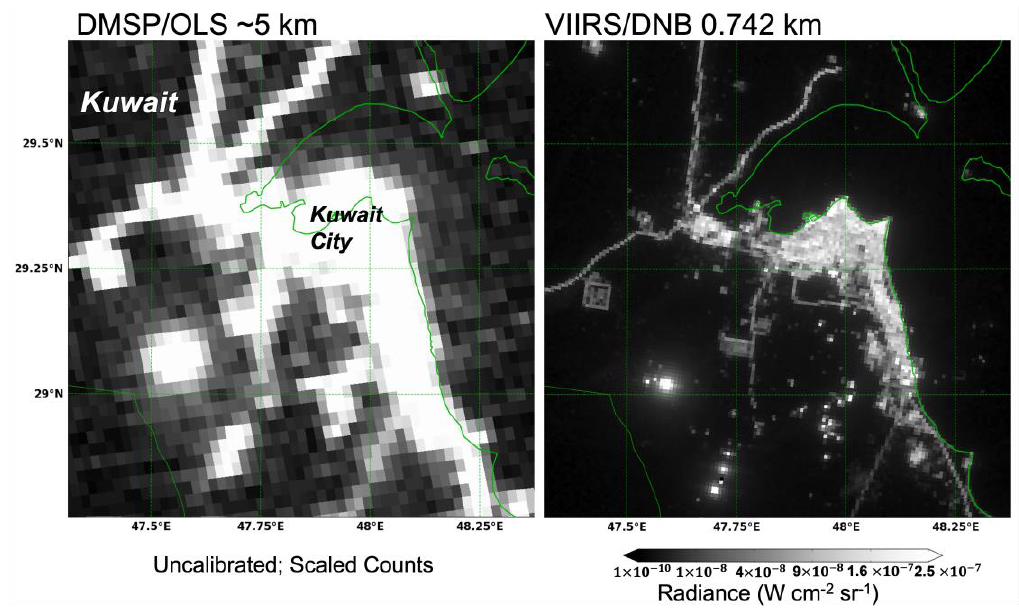
Figure 1. Comparison between a DMSP/OLS and VIIRS DNB image.